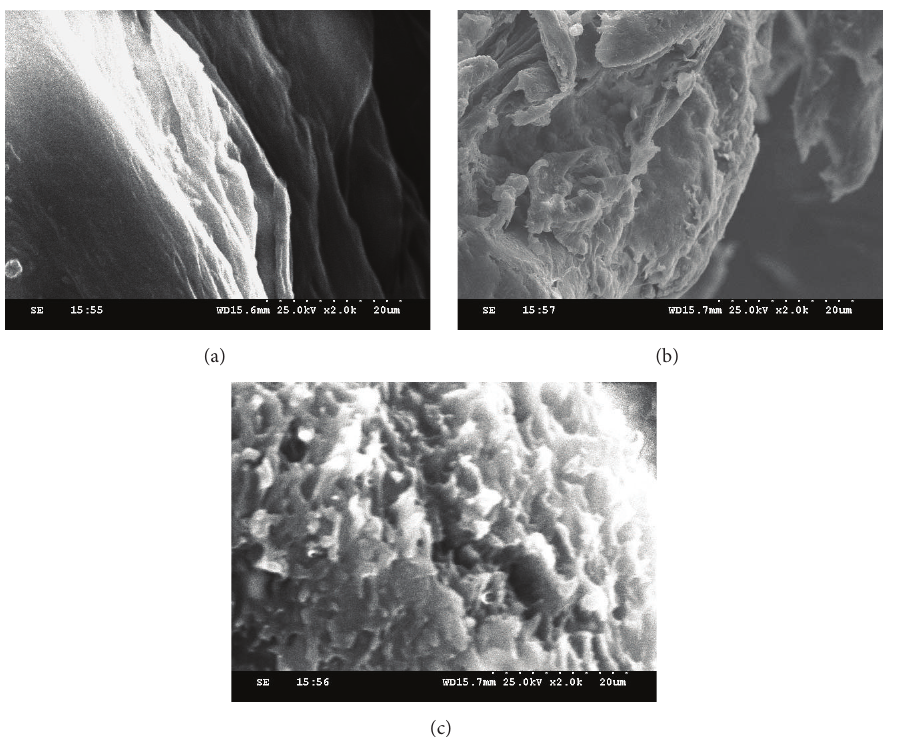
Figure 6: SEM images of the impact break section of blends: (a) PC/PLA (70/30); (b) PC/PLA/TPU (70/30/30); (c) PC/PLA/TPU/DBTO (70/30/30/0.8).